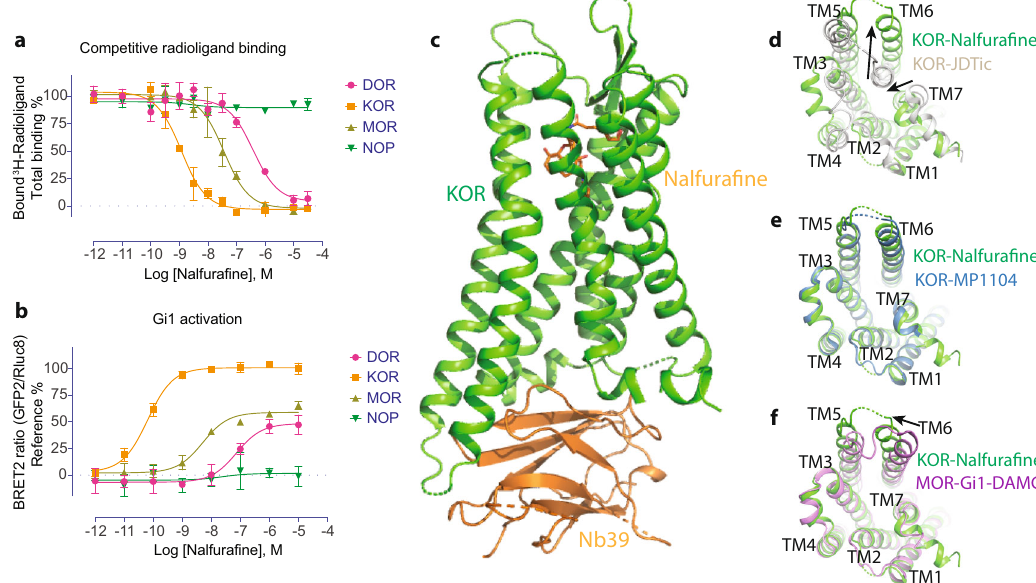
Fig.1|Structureofactive-stateKORboundtonalfura fi ne.a Thebindingaf fi nity of nalfura fi ne at four opioid receptors. 3 H-Diprenorphine was used as radioligands for DOR, KOR, and MOR; 3 H-Nociceptin was used as a radioligand for NOP. b The functional activity of nalfura fi ne at the opioid receptors. References were DPDPE, U50,488,DAMGO,andNociceptinforDOR,KOR,MOR,andNOP,respectively.Data are expressed as the mean±SEM of three independent experiments ( n =3